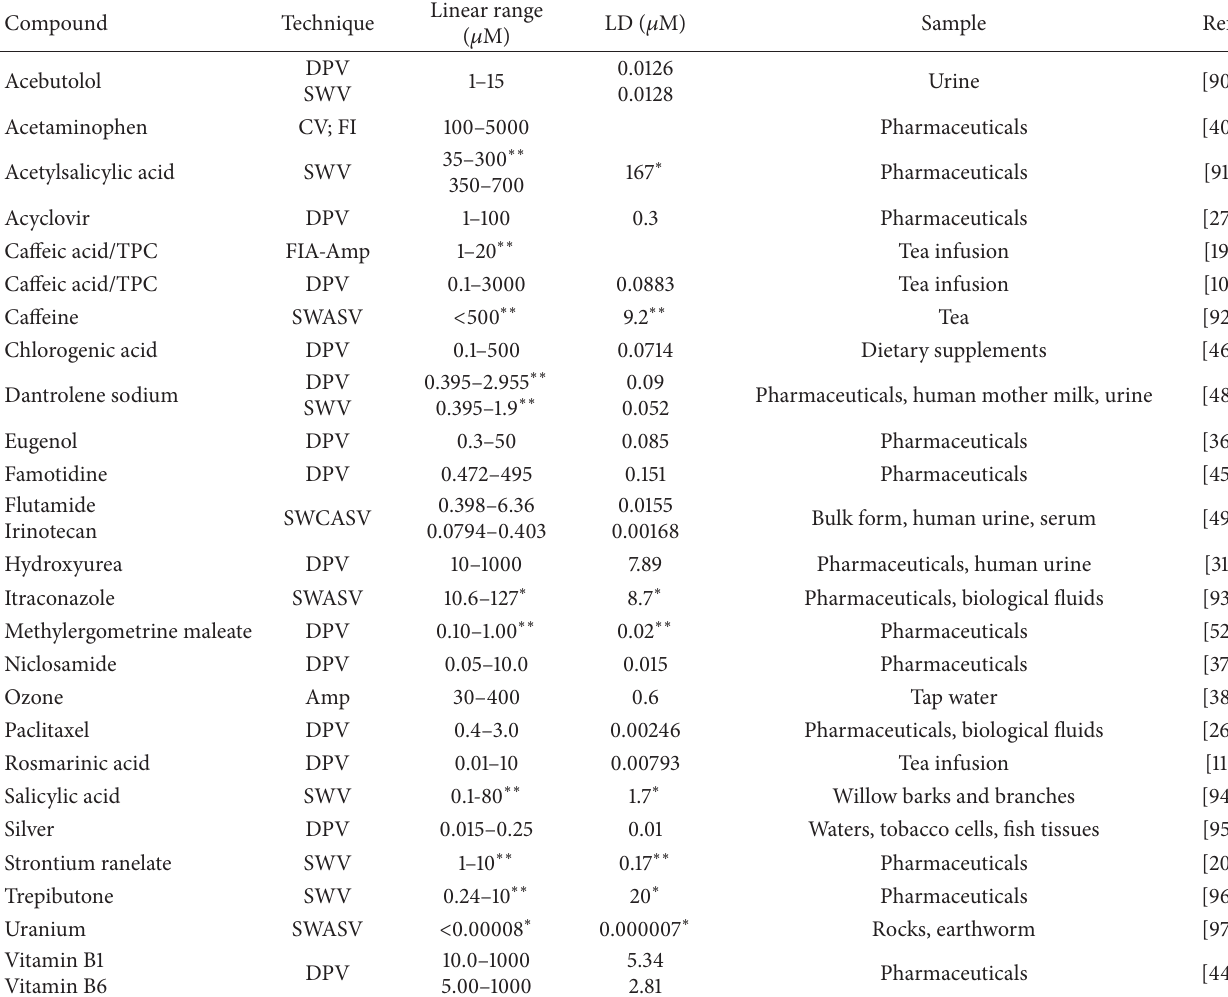
Table 1: Electroanalytical applications of unmodified